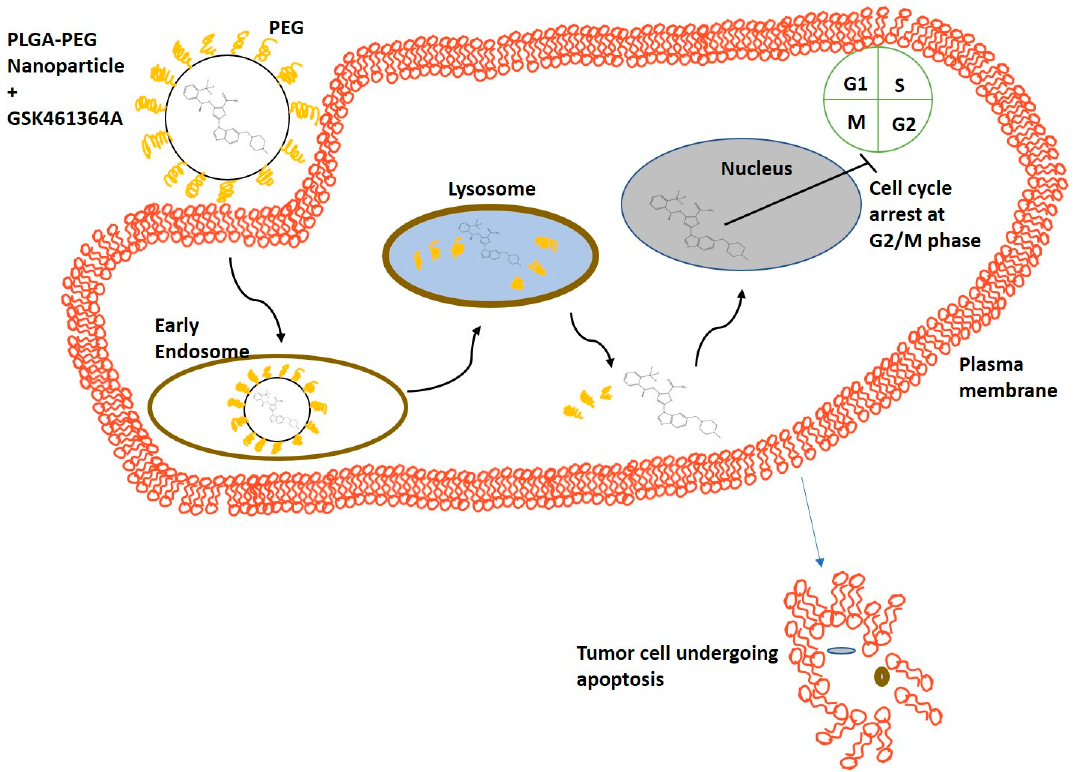
Figure 1. Schematic representing mechanism of action of cellular uptake of PLGA-PEG nanoparticles containing GSK461364A leading to apoptosis of tumor cells.